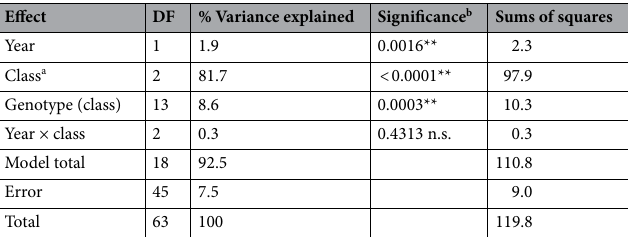
Table 2. ANOVA of pollen exclusion ratings. a Popcorn, PuraMaize (Ga1-s), or dent corn (ga1). b Probability of > F. **, statistically significant at a threshold probability of 0.05. n.s., not statistically significant.